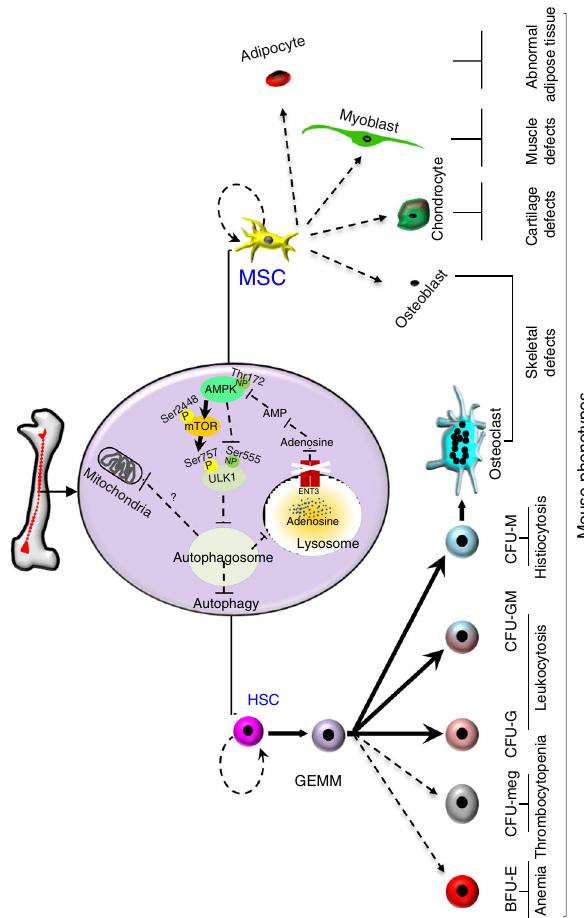
Fig. 10 Schematic representation of disease pathogenesis in Slc29a3 − / − mice. Molecular, cellular and tissue defects in Slc29a3 − / − mice are depicted. Broken lines or arrows indicate inhibitory pathways, and thick arrows indicate the stimulatory pathways occurring in Slc29a3 − / − mice. Phosphorylation statuses of AMPK, mTOR, and ULK in Slc29a3 − / − cells are shown (P, phosphorylated, yellow circle; NP, non-phosphorylated, green circle). CFU, colony-forming unit; E, erythroid; meg, megakaryocyte; G, granulocyte; M, macrophage; GM, granulocyte/macrophage;